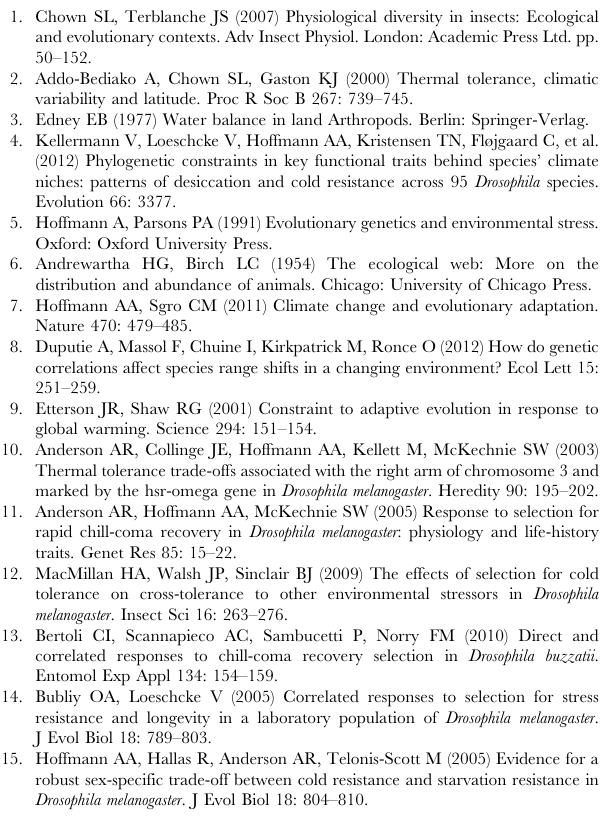
species group (SppG) and subspecies group (SubSppG). * Table S3 Trait means for stress traits and body size under the three environments. Species mean resistance for traits desiccation, cold, heat and starvation resistance as well as body size for the three defined environments hot and dry, hot and wet and cold. Table S4 Trait correlations following correction for body size. Traits were corrected for body size a) across all species b) across the three environments for females and c) across the three environments for males. Values highlighted in bold were significant following sequential bonferroni